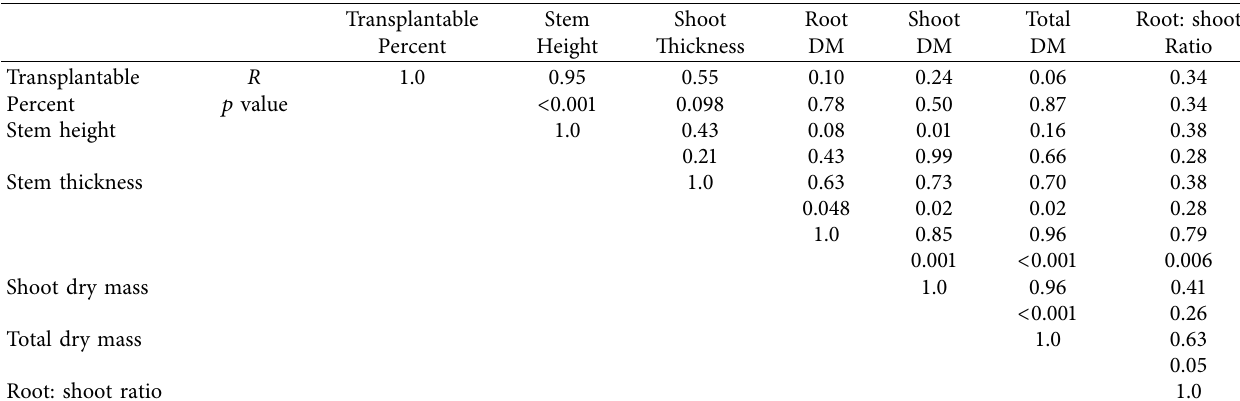
Table 5: Correlation and regression analyses of measured